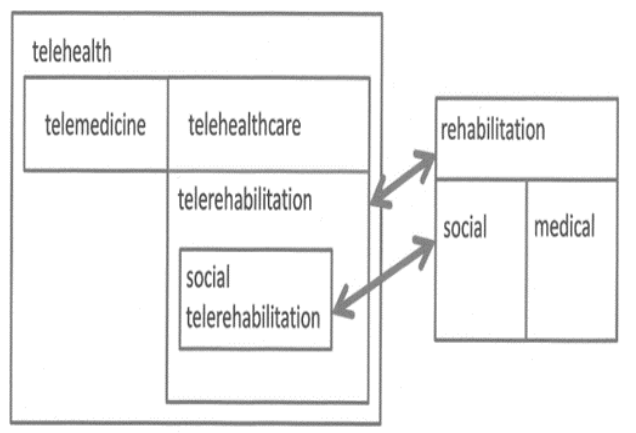
Figure 1. Social telerehabilitation within the telehealth general